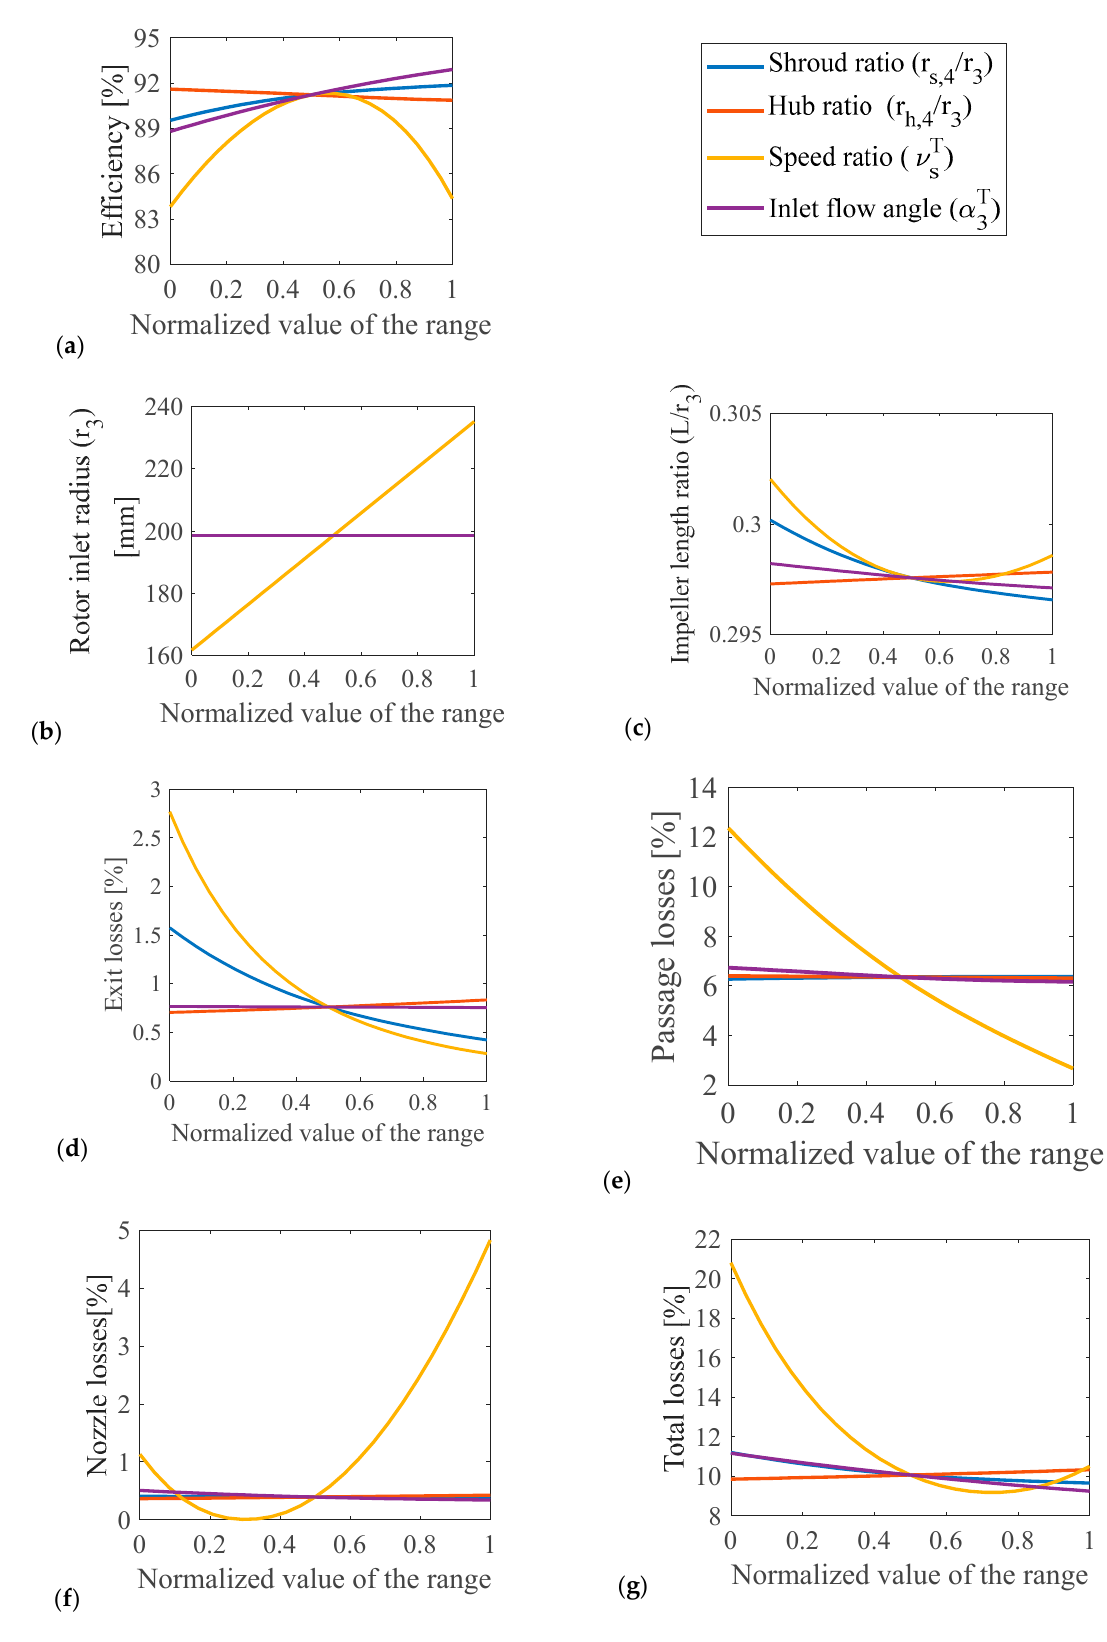
Figure 13. Effect of the design parameter on the turbine performance parameters.